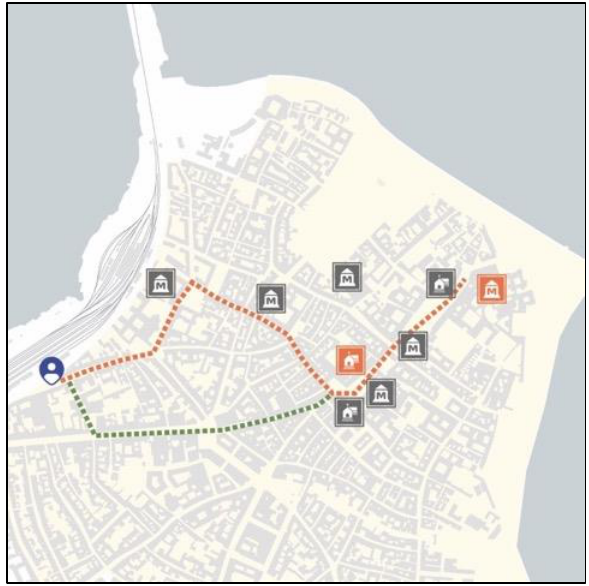
Figure 8. Graphic simulation of the Interactive map proposal for Mantua. Once selected your POIs, with a general indication about their accessibility given by the colour of the icon, the map provides you the shortest/quickest paths through which reaching them and the nearest POIs related to your research. After a first general overview about the level of their accessibility, it is possible to click on the paths and get deeper information about architectural barriers. © Sebastiano Marconcini, 2018